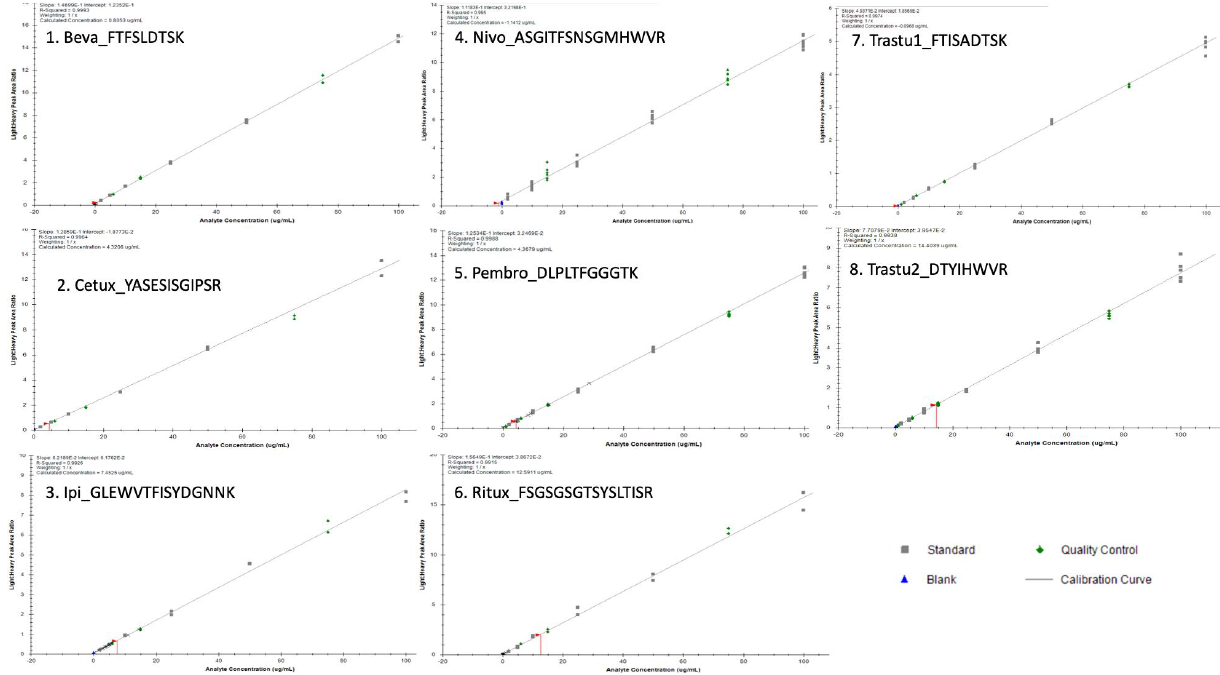
Figure 2. Slopes, intercepts and coefficient of determination mean values were respectively as follows ( n = 6): y = 0.15X + 0.025 ( r 2 = 0.999) for bevacizumab (Beva), y = 0.14X + 0.012 ( r 2 = 0.999) for cetuximab (Cetux), y = 0.052X + 0.26 and ( r 2 = 0.986) for Ipi, y = 0.11X + 0.32 ( r 2 = 0.995) for Nivo, y = 0.13X + 0.032 ( r 2 = 0.998) for pembrolizumab (Pembro), y = 0.16X + 0.044 ( r 2 = 0.996) for rituximab (Ritux), y = 0.05X + 0.018 ( r 2 = 0.997) for trastuzumab_pep1 (Trastu1) and y = 0.08X + 0.040 ( r 2 = 0.994) for trastuzumab_pep2 (Trastu2) where x is the concentration in µ g/mL and y is the area ratio. Selectivity, carry-over and matrix